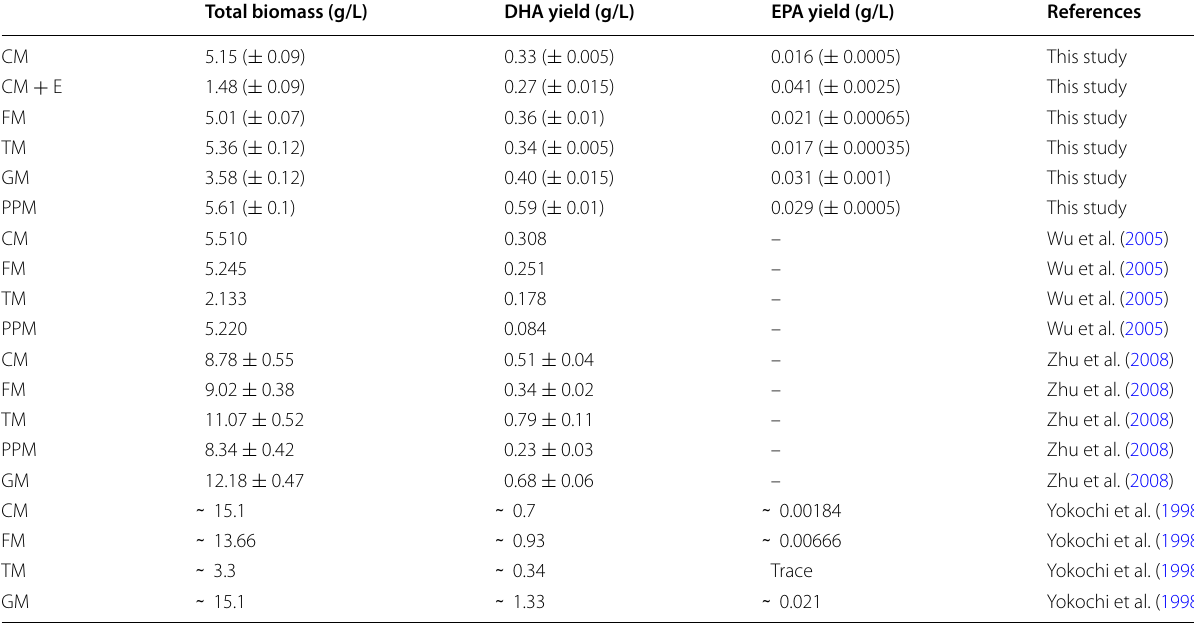
Table 2 Overall comparison of total biomass production and DHA yields and EPA yields for all media